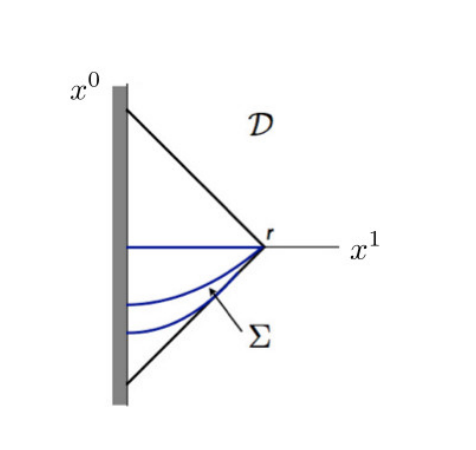
Figure 2 . Choice of di(cid:11)erent Cauchy surfaces (cid:6) inside the interval [0 ; r ). As the Cauchy surface approaches the light-cone, the contribution (cid:1) hHi !